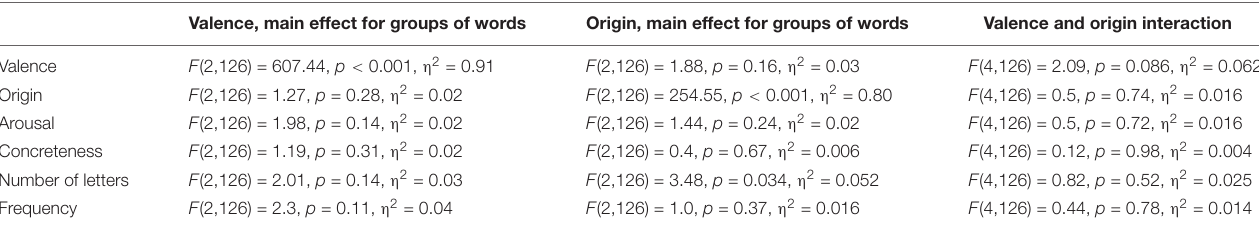
TABLE 2 | Differences between groups of words (valence and